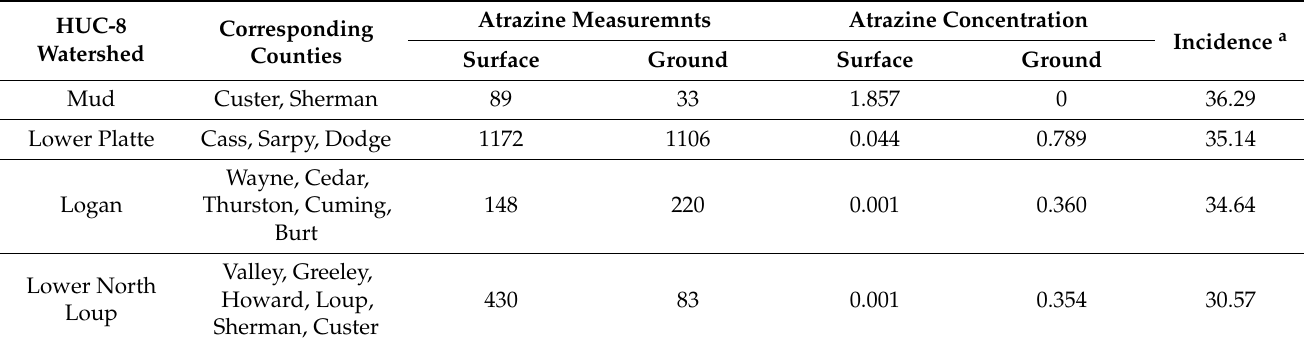
Table 1. Watersheds with higher age-adjusted pediatric cancer incidence and atrazine